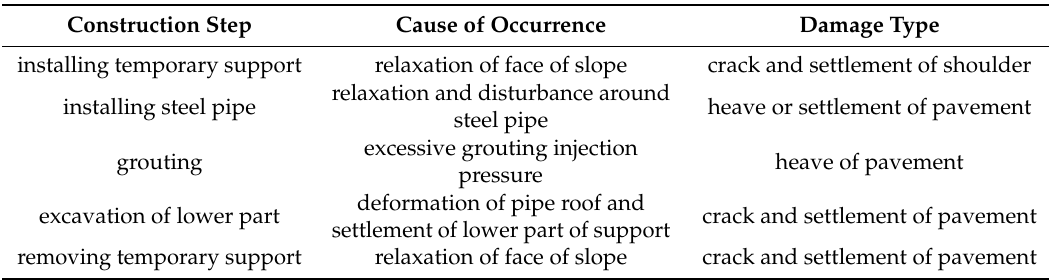
Table 1. Type of pavement damage occurrence possible at each step of construction of the underground multilevel crossing road under the highway, using the non-open-cut method.